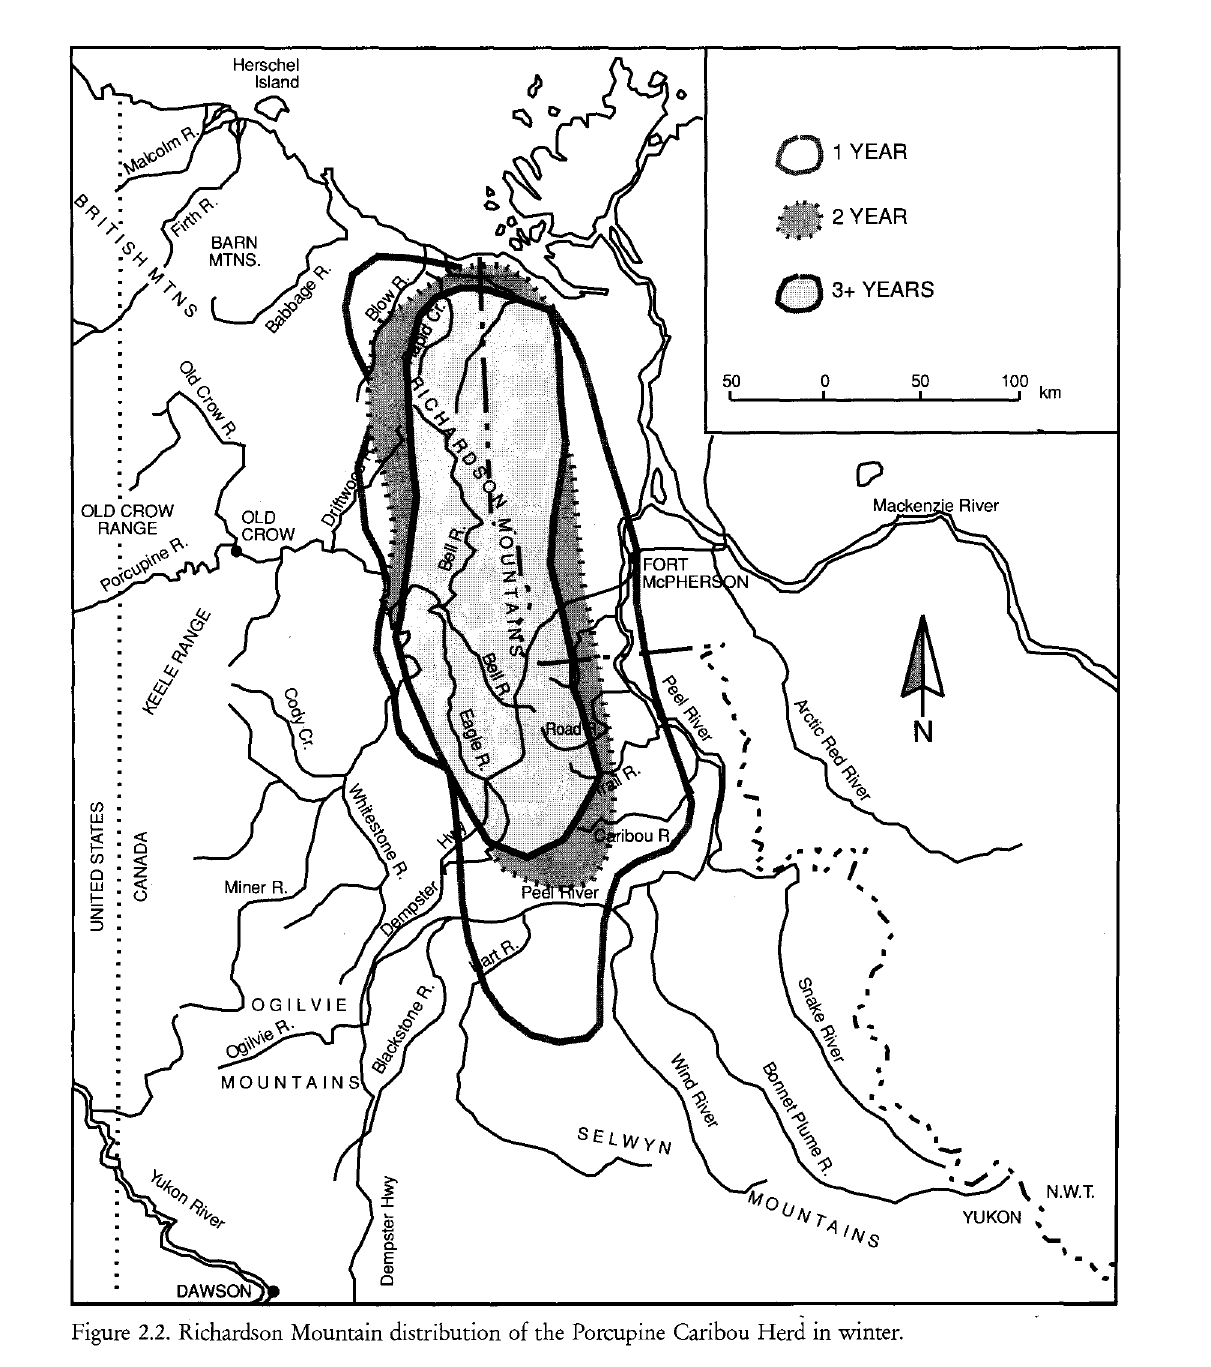
Figure 2.2. Richardson Mountain distribution of the Porcupine Caribou Herd in